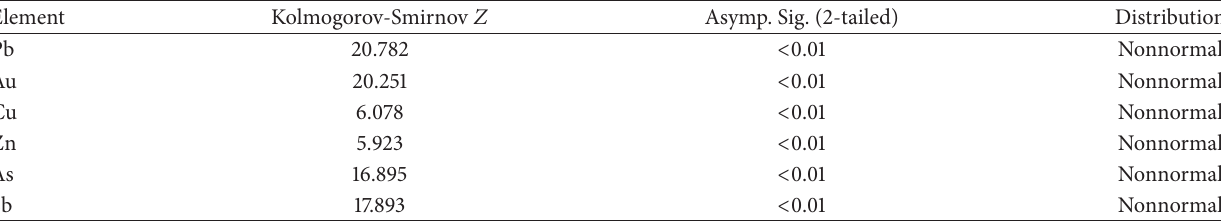
Table 2: Results of the Kolmogorov-Smirnov test on the variables.